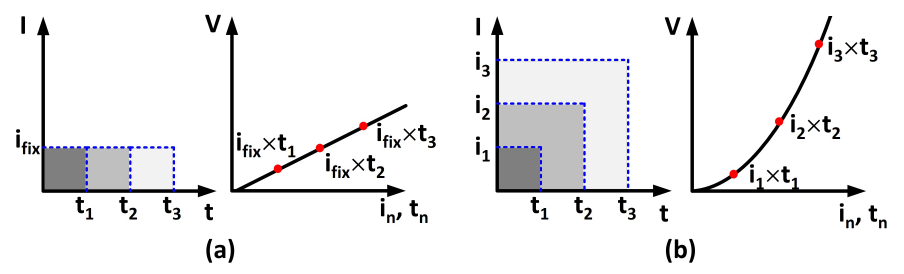
Figure 1. Multiplication based on charging a capacitor using an input current: ( a ) L 1 norm with fixed input current; ( b ) L 2 2 norm with variable input current.